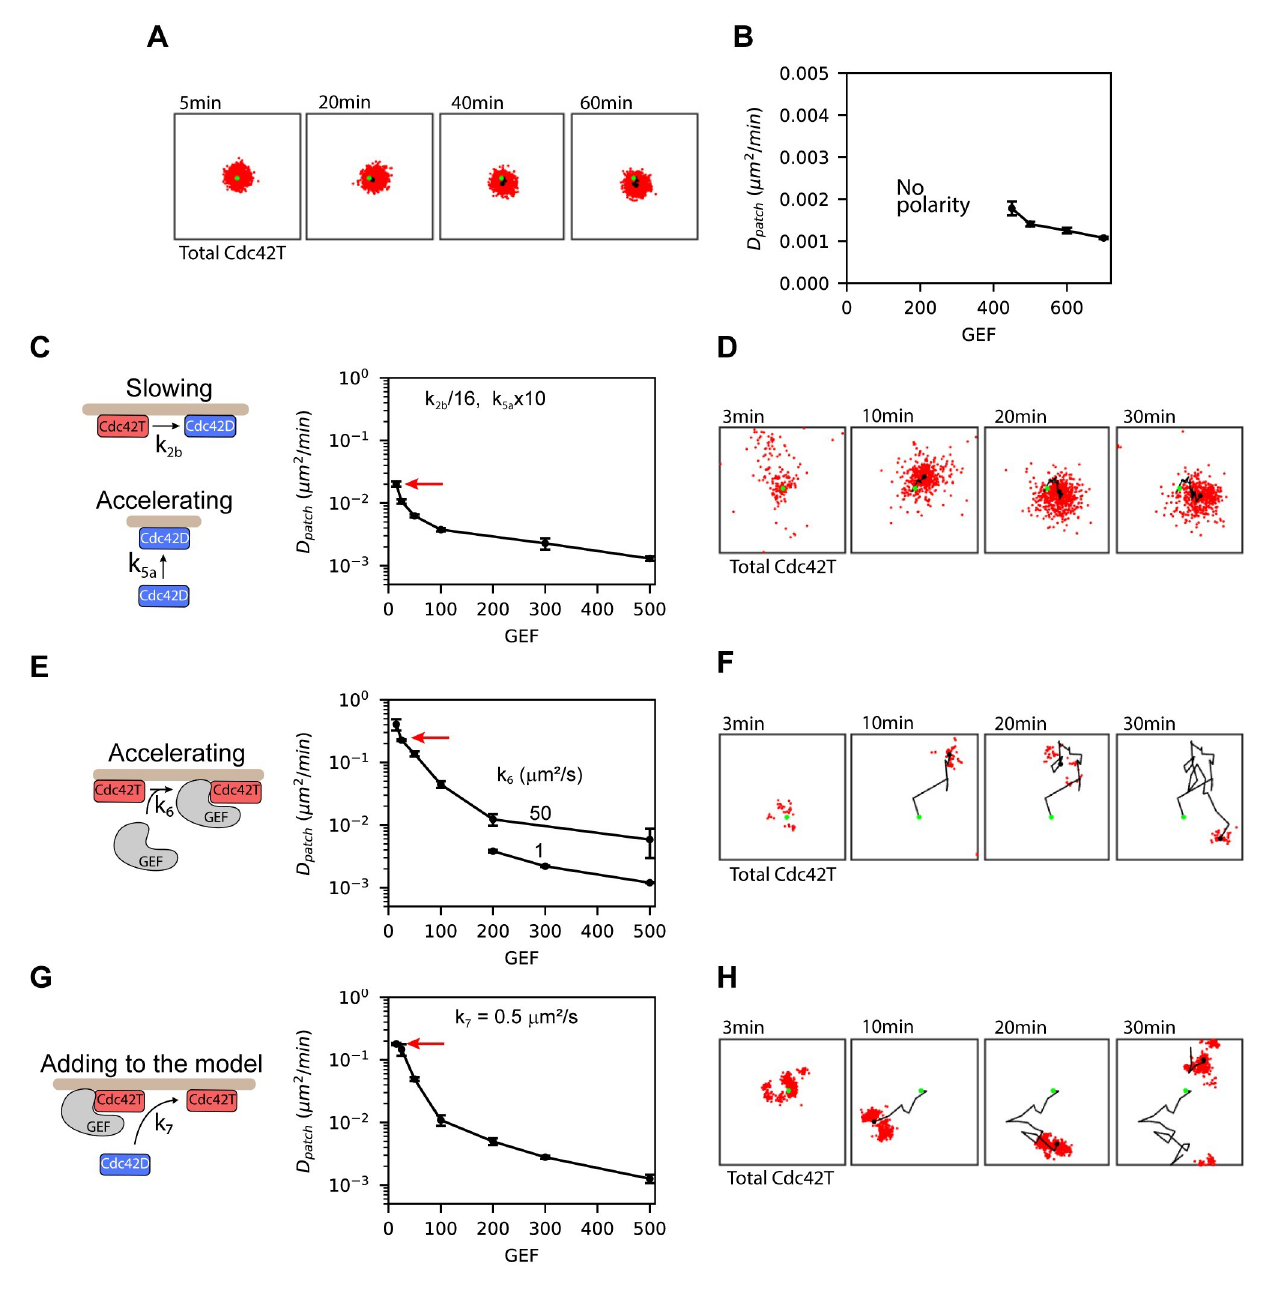
Fig 5. Direct recruitment of polarity factors to the patch enables highly mobile clusters. (A) Snapshots of the distribution of total active Cdc42 over a 1hr simulation. The black dot in each frame is the centroid of the polarity cluster, and the green dot is the centroid when the polarity cluster first formed. (B) Diffusivity of the centroid of the polarity patch ( D ) as a function of the total amount of GEF molecules in the simulations. D was obtained from the patch patch mean squared displacement (MSD) of the patch centroid by fitting the equation MSD( Δ t i ) = 4 D patch Δ t i β to the data, where Δ t i is a particular time interval, and β reflects the degree of anomalous diffusion. (C) Patch diffusivities as a function of total GEF for simulations where k 2b has been decreased by a factor of 1/16 and k 5a has been increased by a factor of 10 relative to the parameters in Table 1. For these simulations β � 1. (D) Snapshots from a representative simulation in (C) as indicated by the red arrow. (E) Patch diffusivities as a function of total GEF for simulations where k has been increased to either 1 μ m 2 /s or 50 μ m 2 / 6 s. With k 6 = 1 μ m 2 /s polarization is lost when the number of GEFs is below 200. With k 6 = 50 μ m 2 /s the simulations show polarization at even lower GEF amounts, in this case, β varied between 0.85 and 1. (F) Snapshots from a representative simulation in (E) as indicated by the red arrow. (G) Patch diffusivities as a function of total GEF after adding Reaction 7 to the model. β values were � 0.85 for the two data points with highest mobilities, and close to 1 for the other points. (H) Snapshots from a representative simulation in (G) as indicated by the red arrow. Error bars for patch centroid diffusivities are standard errors from the least-squares fit use to compute D patch